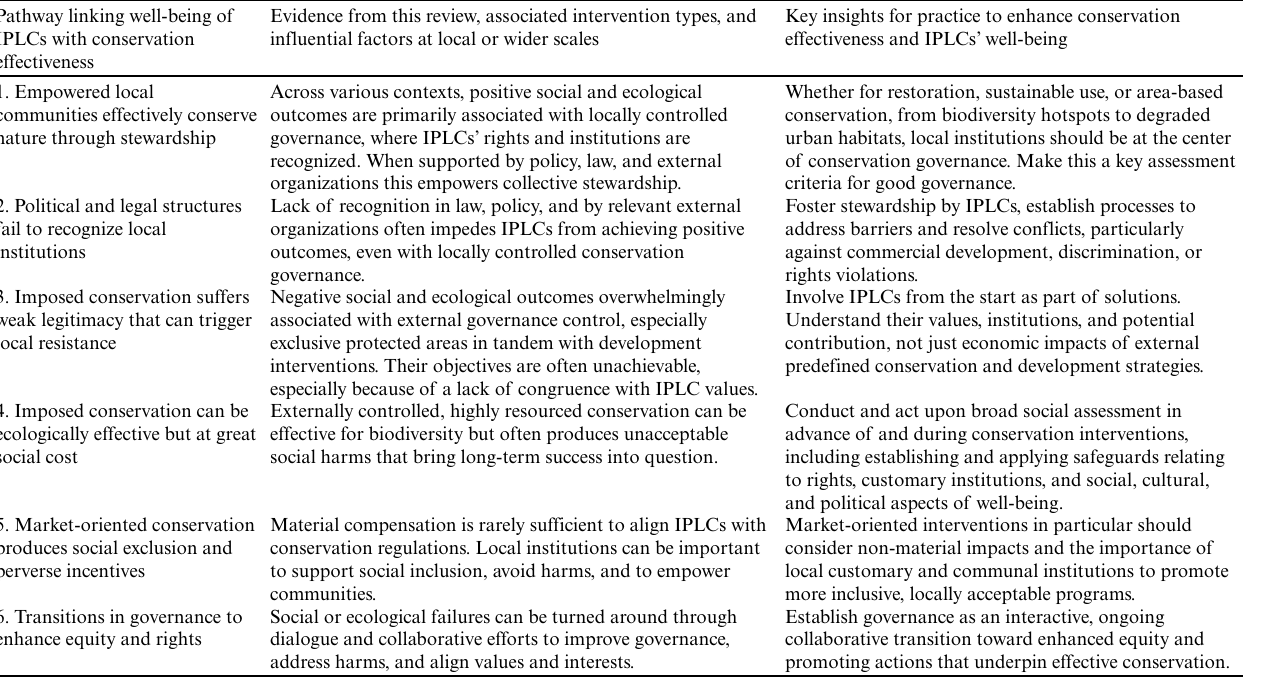
Table 4 . Summary of the main pathways identified through this review linking types of conservation governance with the well-being of Indigenous peoples and local communities (IPLCs) and conservation effectiveness, along with key insights for conservation practice. Pathway linking well-being of IPLCs with conservation